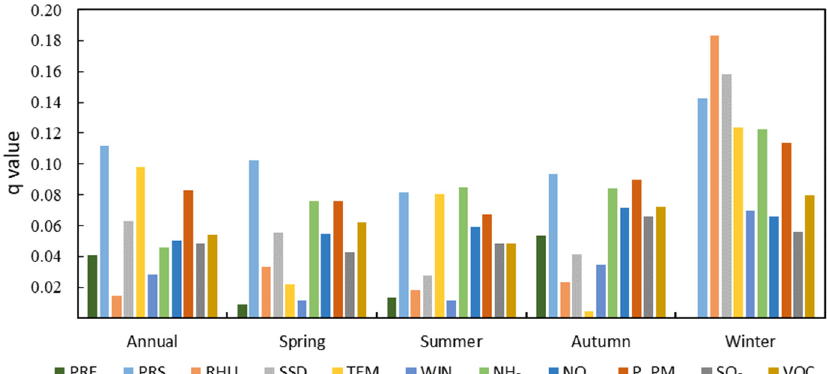
Figure 5. The inter-annual and inter-season q -values of the driving factors on PM2.5 concentrations in the Yellow River Basin. (PRE denotes the accumulated precipitation; PRS denotes the surface air pressure; RHU denotes the 2-meter relative humidity; SSD denotes sunshine duration; TEM denotes air temperature; WIN denotes the 10-meter wind velocity; NH 3 denotes ammonia; NOx denotes nitrogen oxides; P_PM denotes primary PM2.5; SO 2 denotes sulfur dioxide; VOC denotes volatile organic compounds.)